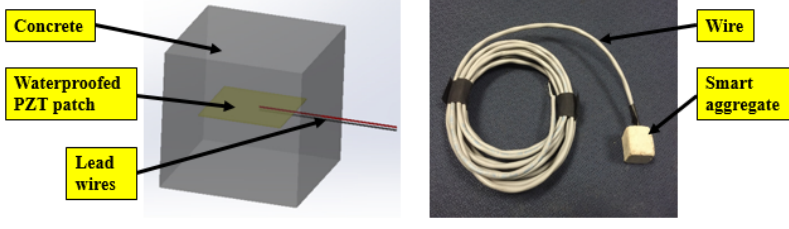
Figure 1. Structure of a smart aggregate. Table 1. The detailed parameters of the lead zirconate titanate (PZT) patch.